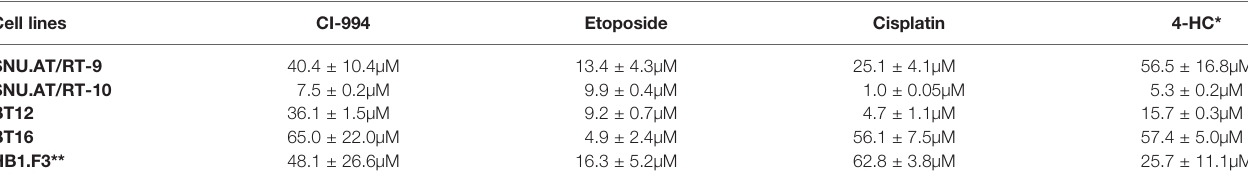
TABLE 2 | IC 50 of each drug in AT/RT cell lines. Cell